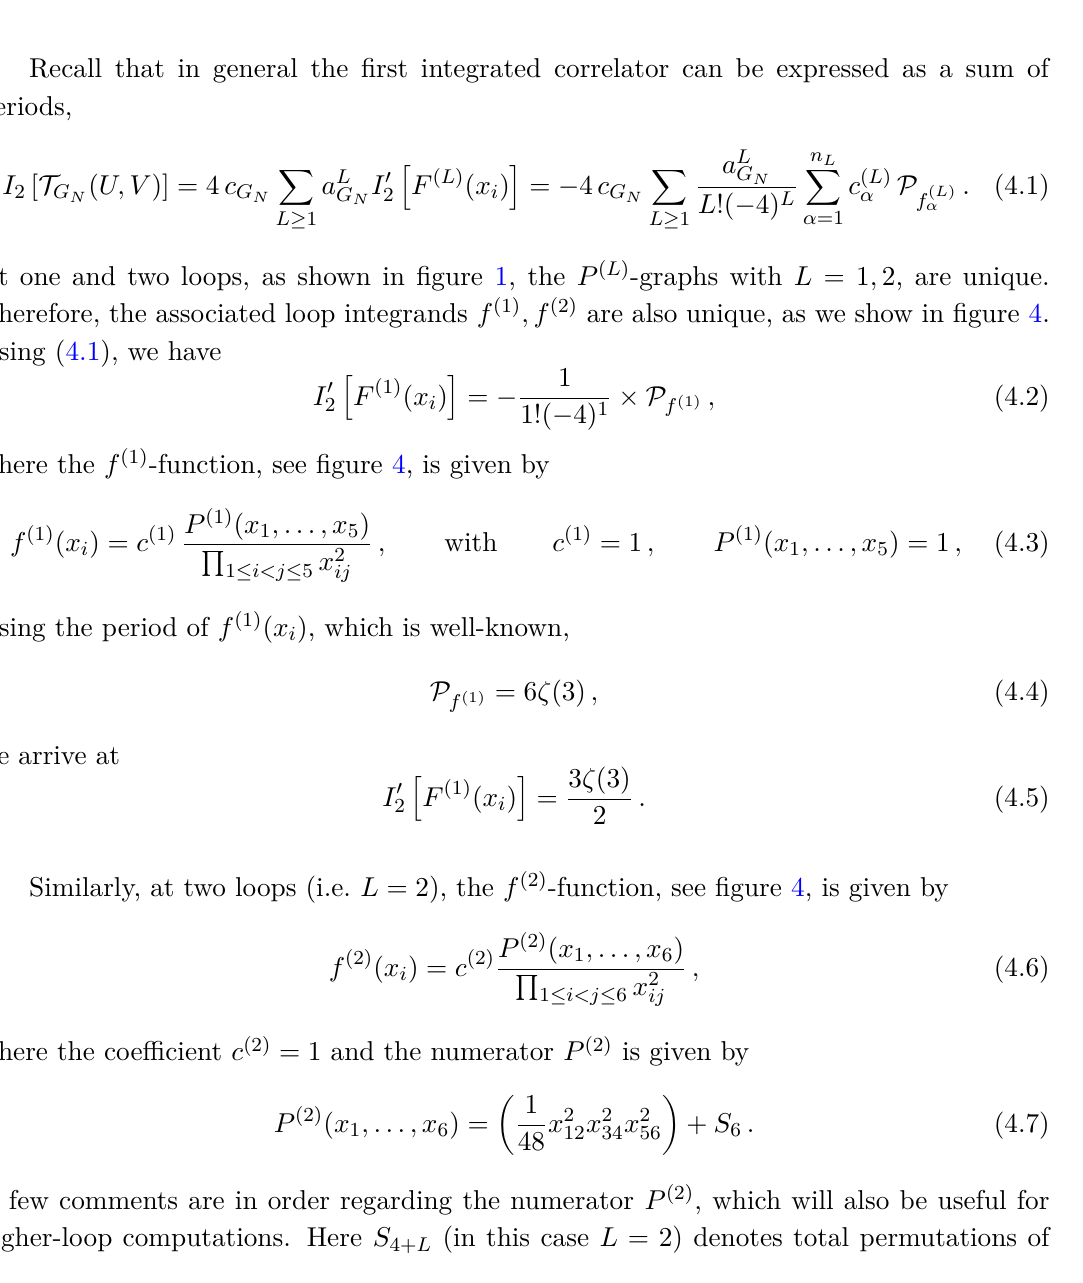
Figure 4. Here we draw the planar f -graphs up to three loops. (They have been given in figure 2 in